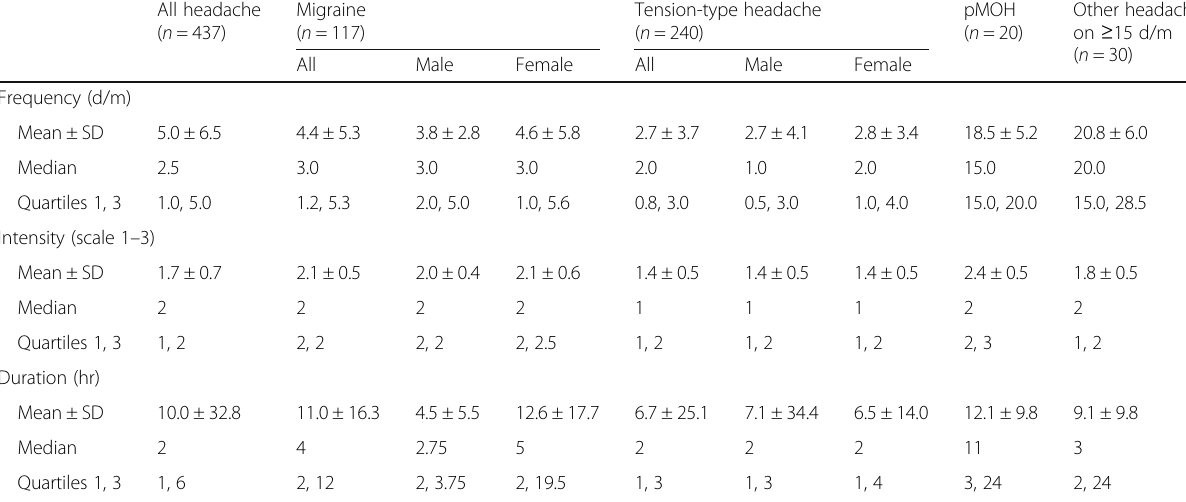
Table 2 Symptom burden by headache type and, for migraine and tension-type headache, by gender All headache ( n =